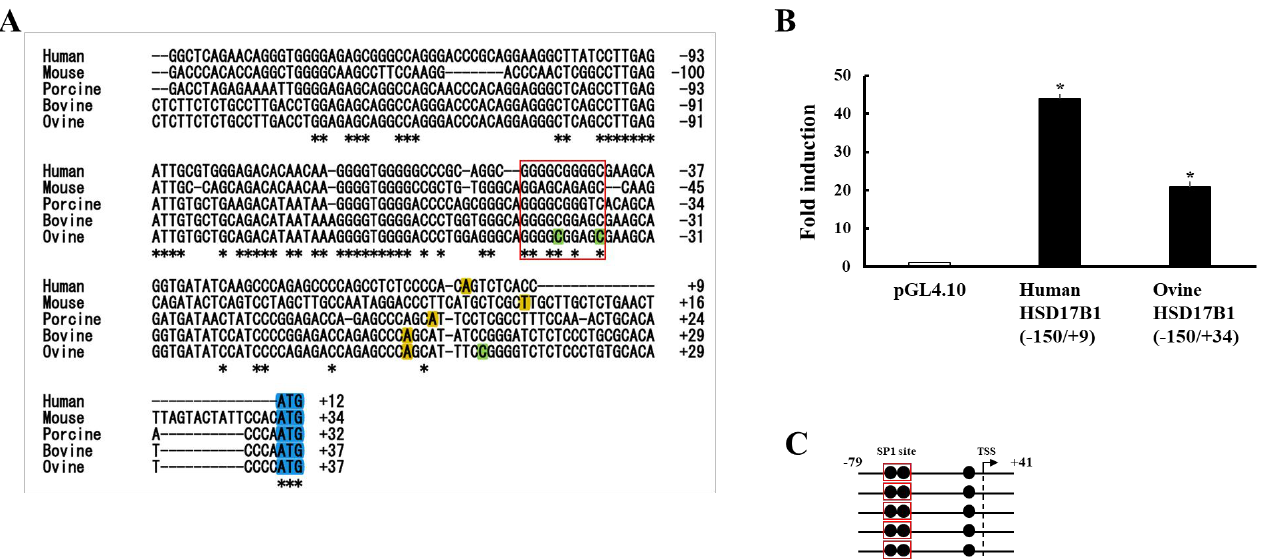
Figure 3. Analyses of HSD17B1 promoter region ( A ) Alignment for the nucleotide sequence of HSD17B1 gene and its 5′-flanking region in human, mouse, porcine, bovine, and ovine. The asterisks (*) are the conserved nucleotides among all species. The conserved SP1 site is shown by a redline box. Putative transcription start and translation start sites are shown by the yellow and blue boxes, respectively. Cytosine bases in CpG dinucleotides of ovine HSD17B1 promoter region are shown by green boxes. ( B ) Activation of human and ovine HSD17B1 promoter in human placenta-derived JEG-3 cells. Each vector was transfected by lipofection into JEG-3 cells. At 48 h after transfection, luciferase assays were performed using the cell lysates. Values of the pGL4.10 Basic vector were defined as 1. Data are the mean ± SEM values of four independent experiments * p < 0.05 vs. pGL4.10. ( C ) Methylation analysis of the promoter region (−79 to +41) of the HSD17B1 gene in the ovine placenta. The methylation pattern of individual bisulfite-sequenced clones is indicated. Each circle denotes cytosine bases in CpG dinucleotides, and filled circles represent methylated and unmethylated cytosines, respectively.